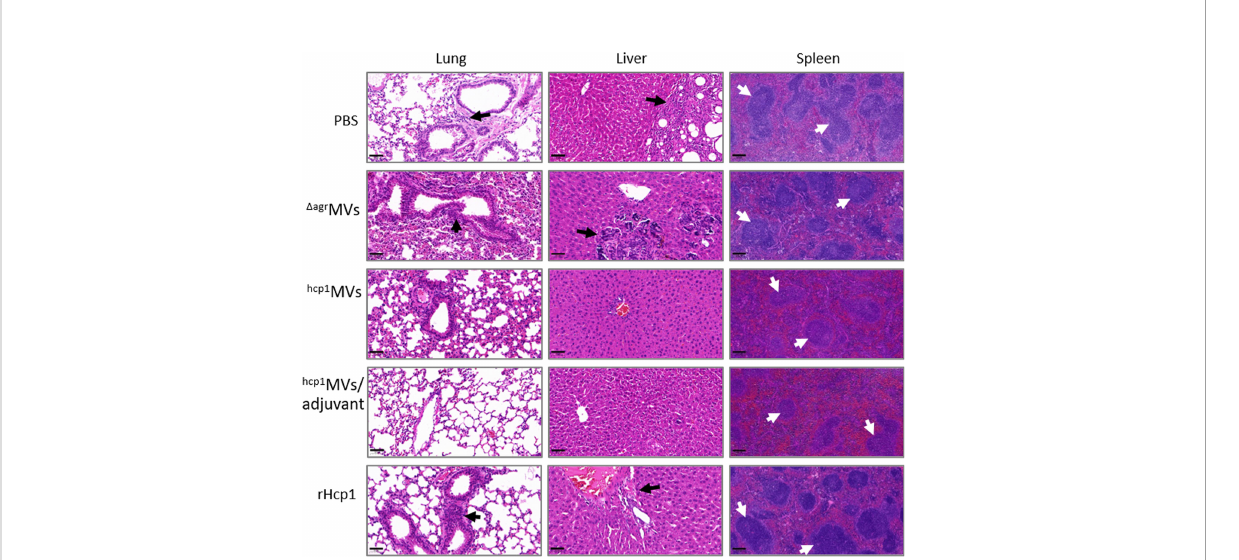
FIGURE 7 Reduced organ in fl ammations in vaccinated mice after exposure to B. pseudomallei . The lungs, livers, and spleens ( n = 2 per group) of vaccinated mice on day 5 postchallenge were collected and fi xed in 10% formalin. Then, tissues were paraf fi n-embedded, sectioned, stained with hematoxylin and eosin, and subjected to pathological examination. The representative fi eld for certain tissues was observed at 20× (bar = 50 µm, lung and liver) and 10× (bar = 200 µm, spleen) magni fi cations under a microscope. White arrows indicated multinucleated giant cells, whereas black arrows showed in fl ammatory in fi